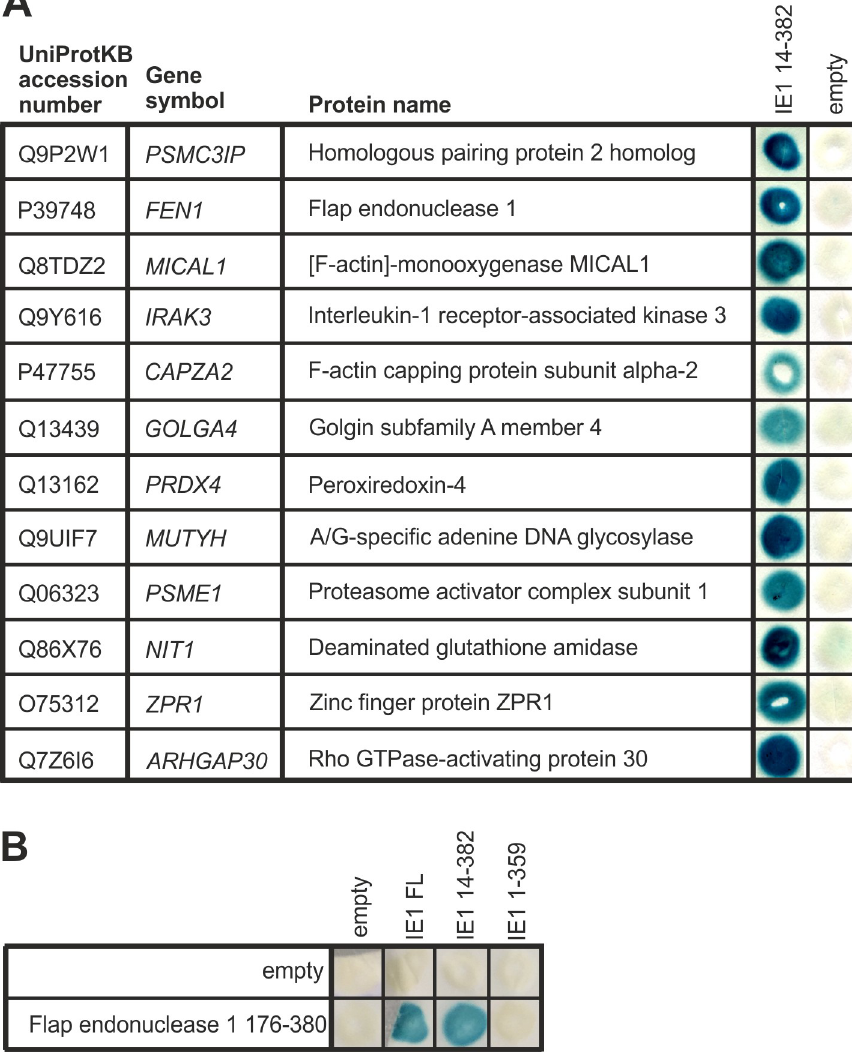
Fig 1. Identification of Flap endonuclease 1 as novel interactor of HCMV IE1. Yeast cells Y153 were transformed with two separate vectors, one of which encoded a GAL4 activation domain (AD) in fusion with the indicated cellular protein, the second plasmid encoded a GAL4 DNA-binding domain (DBD) in fusion with the respective IE1 versions. Thereafter, yeast colonies were selected for the presence of both plasmids on dropout medium lacking tryptophan and leucine and subsequently analyzed for the expression of β -galactosidase. (A) Interaction analysis between HCMV IE1 14–382, which serves as yeast two-hybrid screen bait, fused to the GAL4 DBD and the putative novel interactors as fusions with the GAL4 AD. (B) Interaction analysis between Flap endonuclease 1 in fusion to the GAL4 (AD) and HCMV IE1 as full length (FL) or truncated (14–382 and 1–359) versions as fusions with the GAL4 DBD.